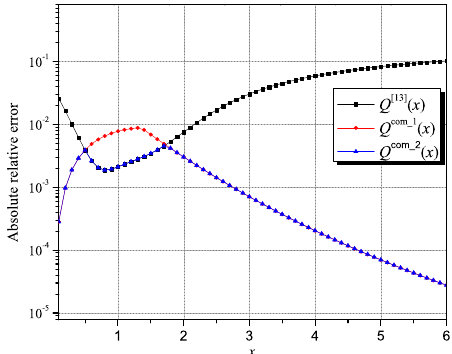
Figure 3. The comparison of the absolute relative errors of the two novel interval upper-bound approximations of the Q -function with the one from